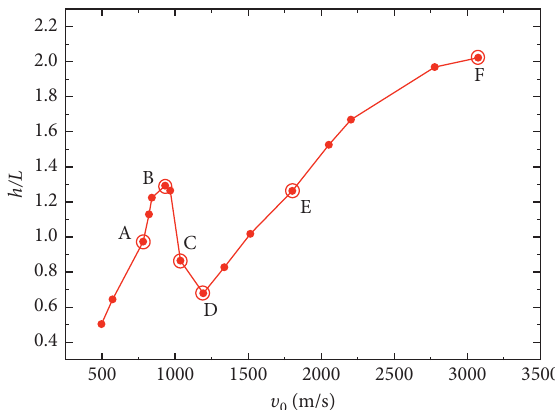
Figure 6: The curve of DOP vs. the impact velocity.